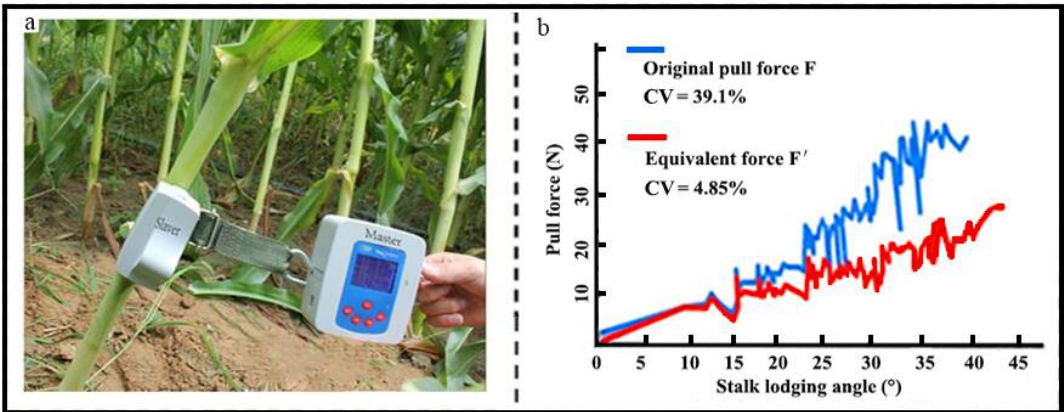
Figure 4. The pull force is exerted on a position of 440 mm above the ground and close to the fourth internode of the corn stalk. ( a ) The prototype of the measurement device applied in the field experiment of corn stalk lodging under the action of pull force F ; ( b ) the original pull force F fluctuated significantly with a CV of 39.1% along with stalk lodging angles ranging from 0° to 45°, while the equivalent force was much more stable (CV of 4.85%).